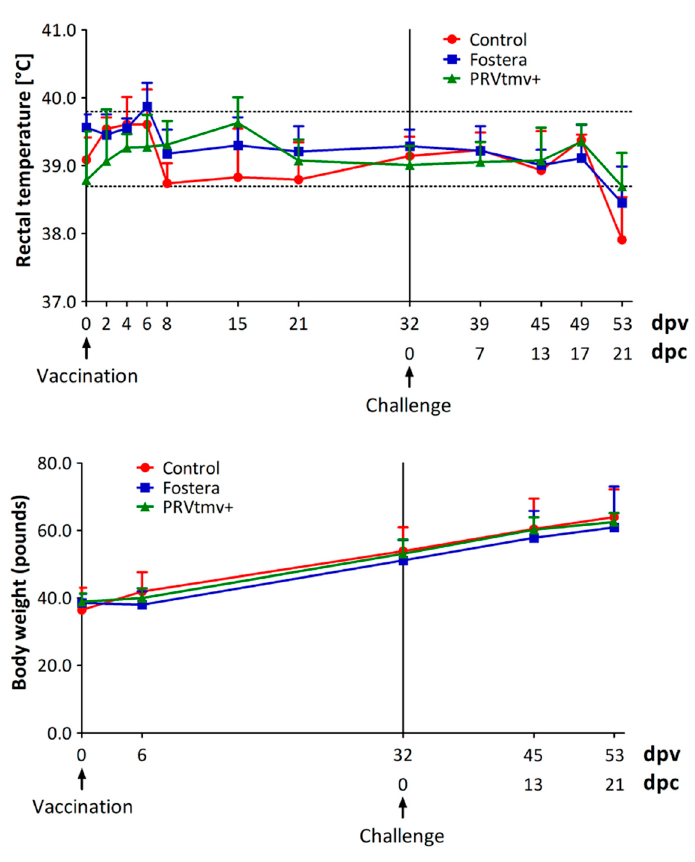
Figure 8. Clinical assessment. ( A ) Rectal temperature of pigs following immunization and challenge. Rectal temperature was measured using a digital thermometer on indicated days. Shown is the mean temperature of each treatment group with standard deviation (SD) ( n = 5). ( B ) Body weight (BW) of pigs following immunization and challenge. BW was measured using a digital weight balance on indicated days. The mean BW of each treatment group with SD ( n = 5) is shown. dpv—days post-vaccination; dpc—days post-challenge. Two-way ANOVA followed by Bonferroni post-tests to compare replicate means by row. p < 0.05 is considered as significant.